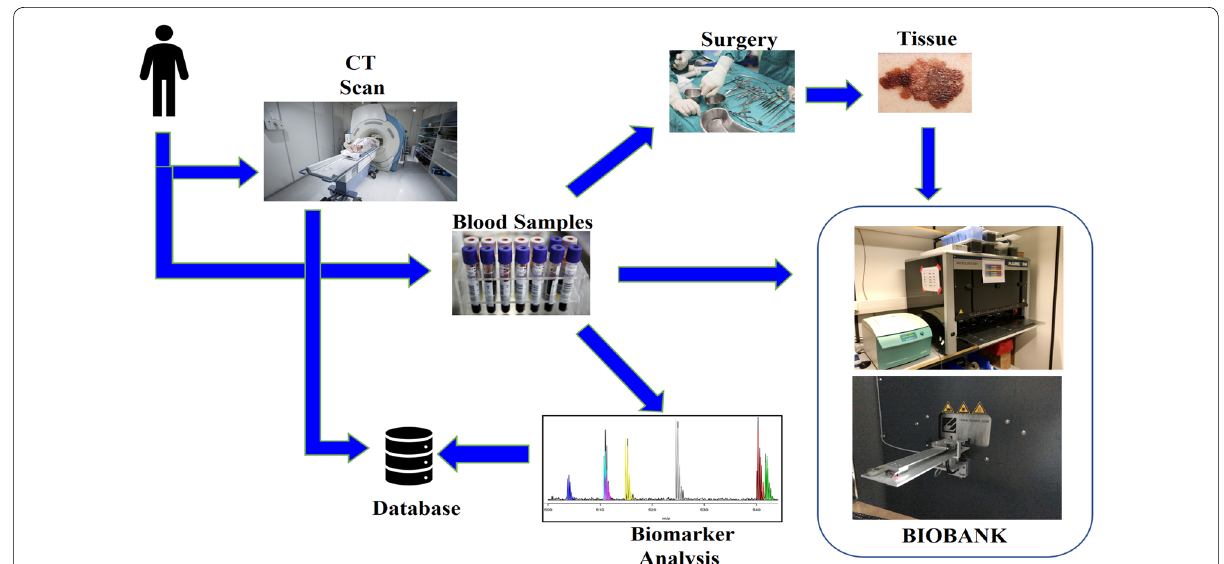
Fig. 3 Schematic illustration of the biobank workflow that has been developed and implemented in Lund. Blood and tissue samples (primary tumour and metastases) are stored in the automated biobank and can be used in research projects, e.g. aiming at finding new